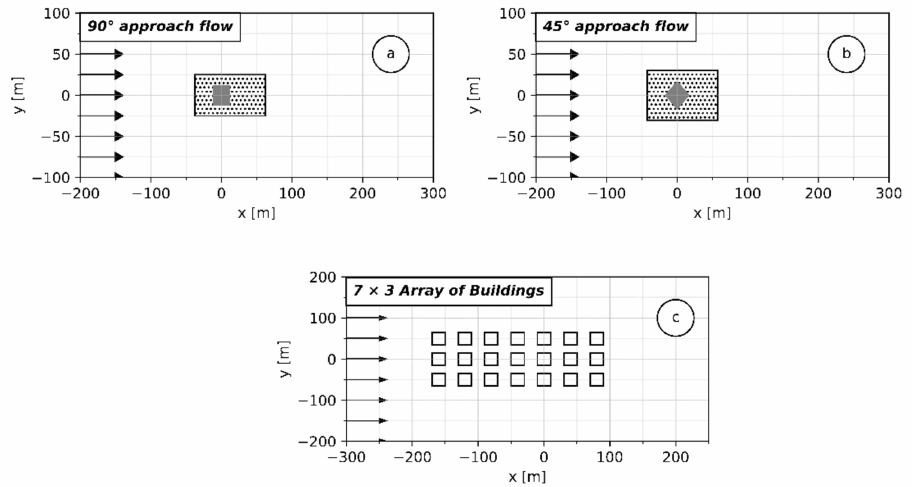
Figure 4. Geometrical representation of the test cases ( a ) test case c3 cube with 90 ◦ approach flow,